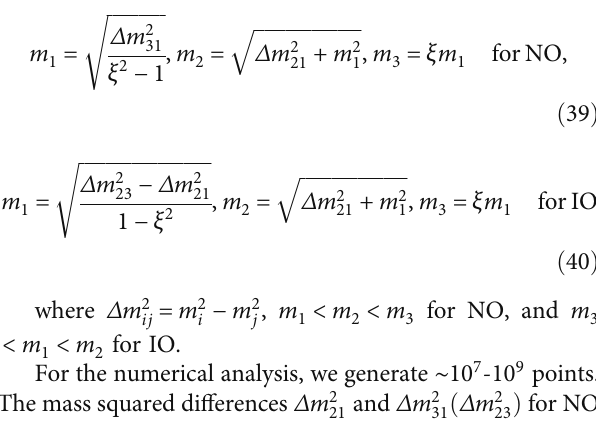
Normal ordering (best fi t)